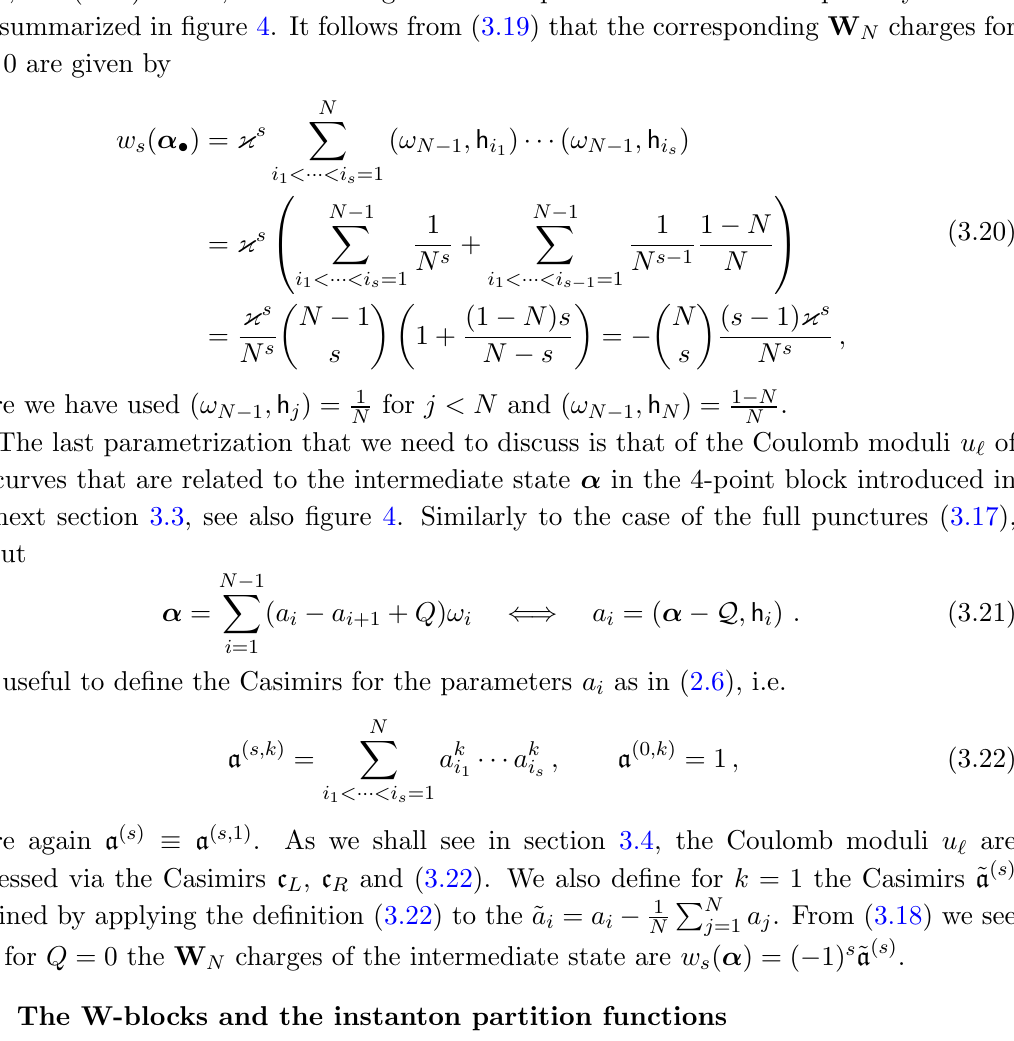
Figure 4 . This (cid:12)gure illustrates the parametrization of the primary (cid:12)elds of the Toda CFT for the 3 and 4-point case. It indicates in particular which (cid:12)elds are full and which are simple punctures. block, see (3.22) below, as well as (cid:12)gure 2. The parametrization of the primary (cid:12)elds